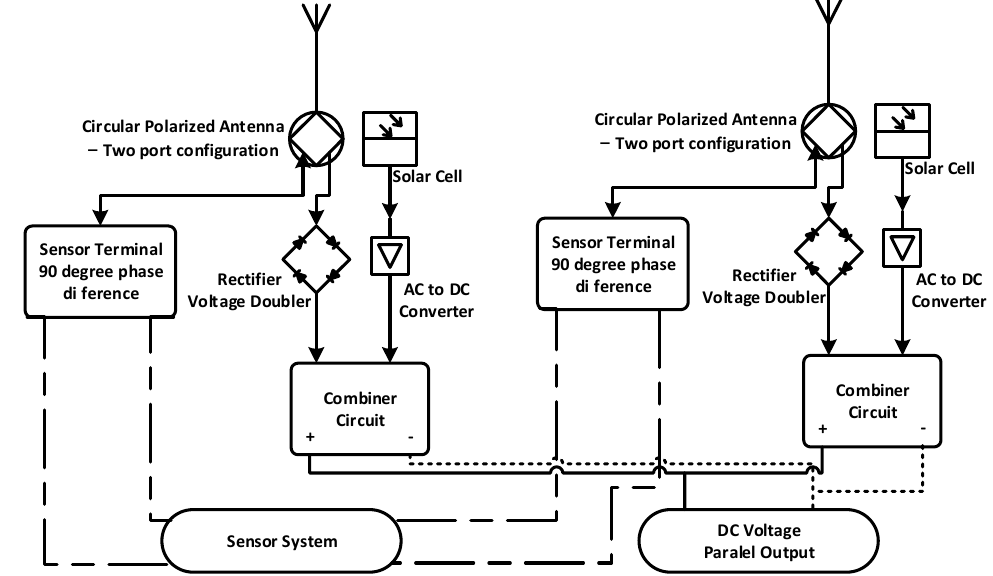
Figure 1. Schematic of the CP Antenna with a 2 × 4 Hybrid Coupler.